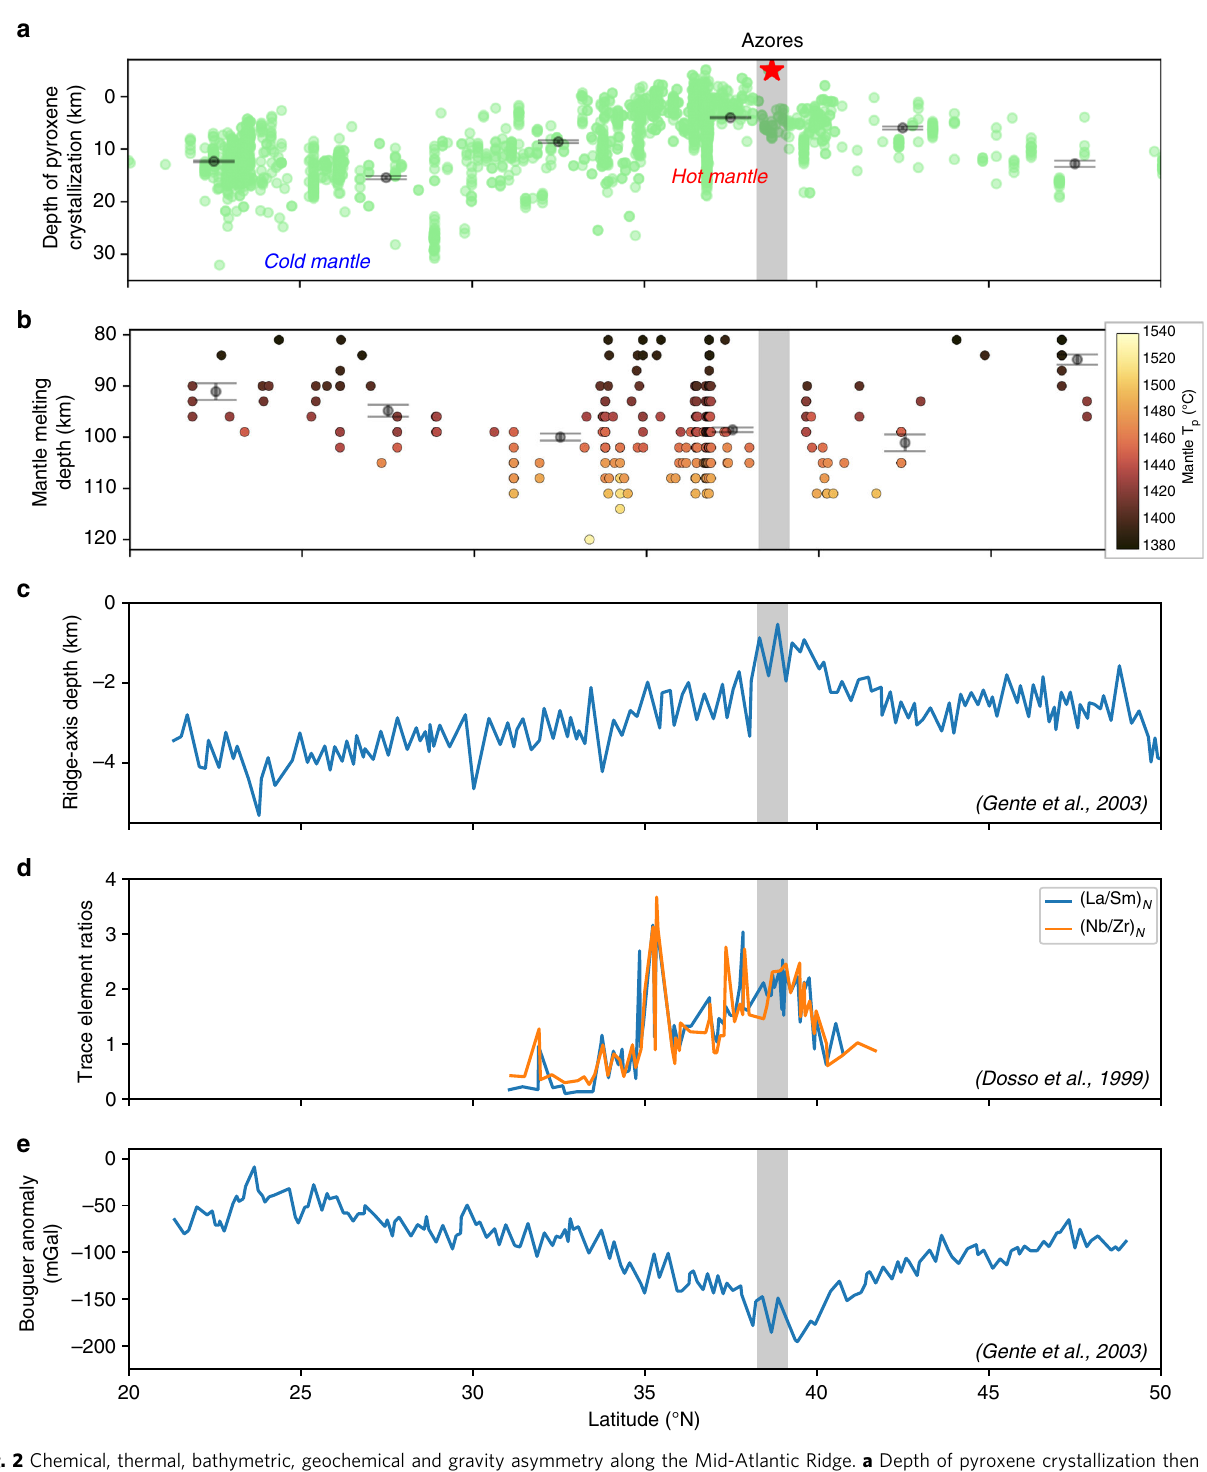
Fig. 2 Chemical, thermal, bathymetric, geochemical and gravity asymmetry along the Mid-Atlantic Ridge. a Depth of pyroxene crystallization then subtraction (e.g. fractionation) in a primary magma that, later, will give birth to MORBs, calculated using Equation (6) in Herzberg 34 and assuming a ratio of 1:3 between pressure (kb) and depth (km). b Mantle depth at which adiabatically upwelling mantle below the MAR segments crossed their solidus, depending on their potential temperature ( T P ) calculated with PRIMELT3 MEGA software 60 using reduced conditions (Fe 2 + / ∑ Fe = 0.9) in the source. Solutions of calculation have been fi ltered for MgO < 8 wt% (blue dots in Supplementary Fig. 2). Mean values and the associated standard deviations (grey points and bars) in a , b are obtained by bootstrap analysis, are reported at 5° step of latitude. c Ridge-axis depth (below sea-level) in the region of the Azores 45 . d Geochemical trace element ratios along the MAR 12 , normalized according to Bougault and Treuil 61 . e Ridge-axis Bouguer anomaly 45 . Data have been plotted against latitude along the